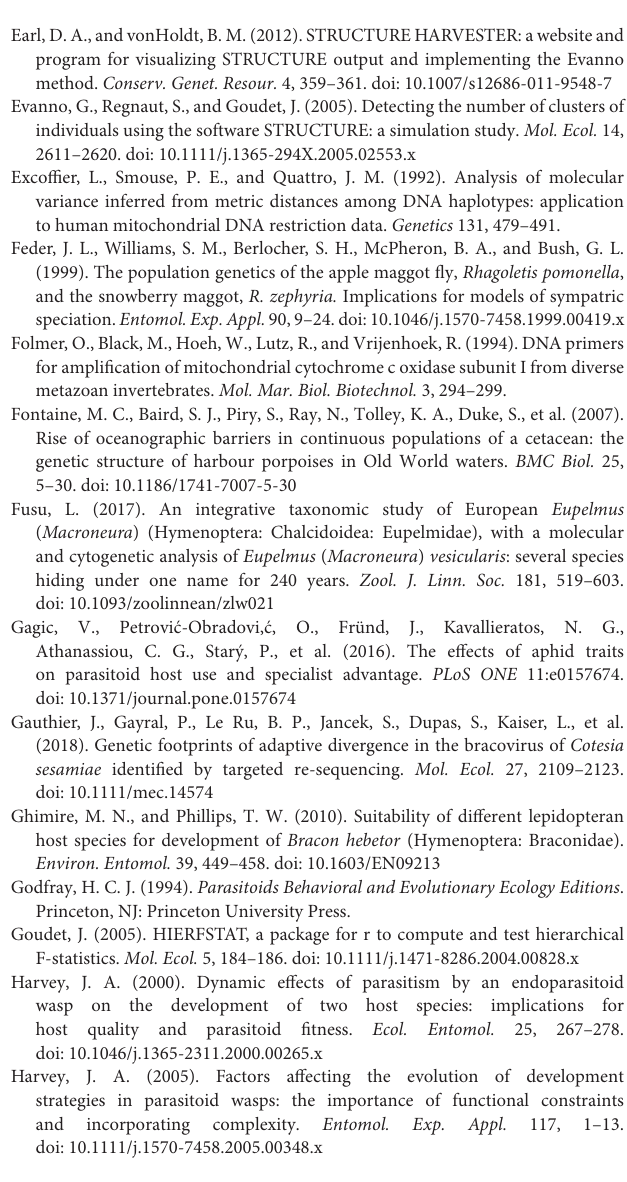
larvae. Above: table with the results for Blastn similarity searches against NCBI nr database. Below: list of COI